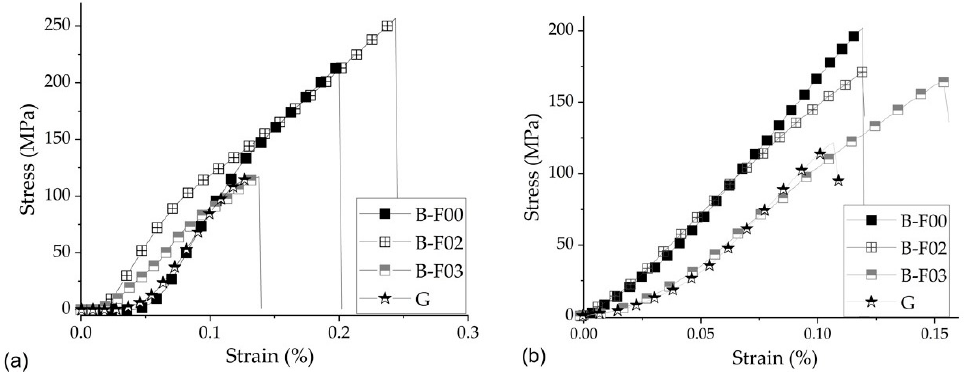
Figure 4. ( a ) The strain–stress curve of compression test; ( b ) traction strength test.